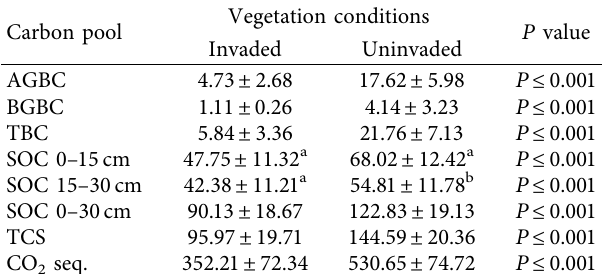
Table 2: Mean ( ± SD; N � 75) biomass carbon stock, SOC, total carbon stock (Mg C/ha), CO 2 sequestration (Mg C/ha of CO 2 seq.), and results of independent t -test (at α � 0.05).